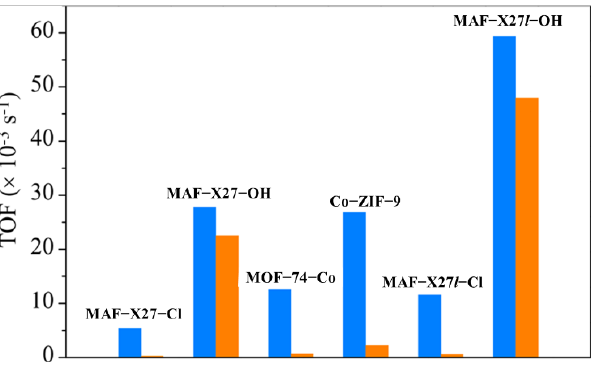
Figure 3. TOF values for the photocatalytic reduction of CO 2 to CO at 1.0 atm (blue) and 0.1 atm (orange). Reprinted with permission from Ref. [71]. 2018 Wang, Y.; Huang, N.-Y.; Shen, J.-Q.; Liao, P.-Q.; Chen, X.-M.; Zhang, J.-P.